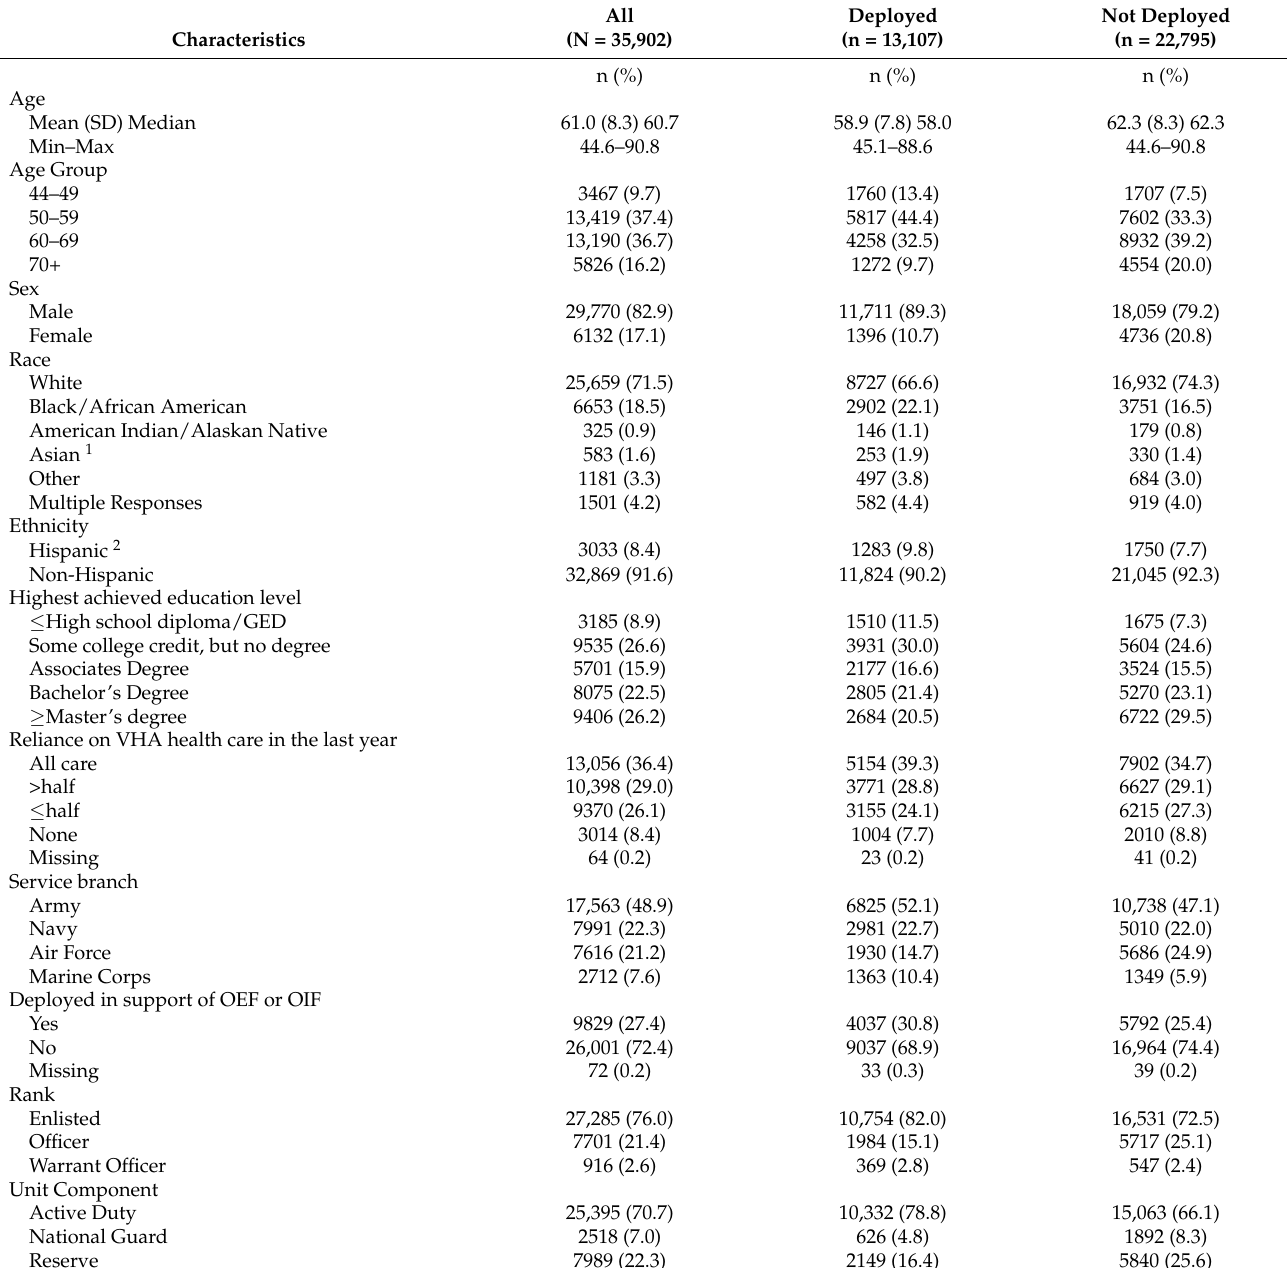
Table 1. Characteristics of Gulf War Era Veterans in the VA CSP 2006/MVP 029 cohort by deployed and non-deployed